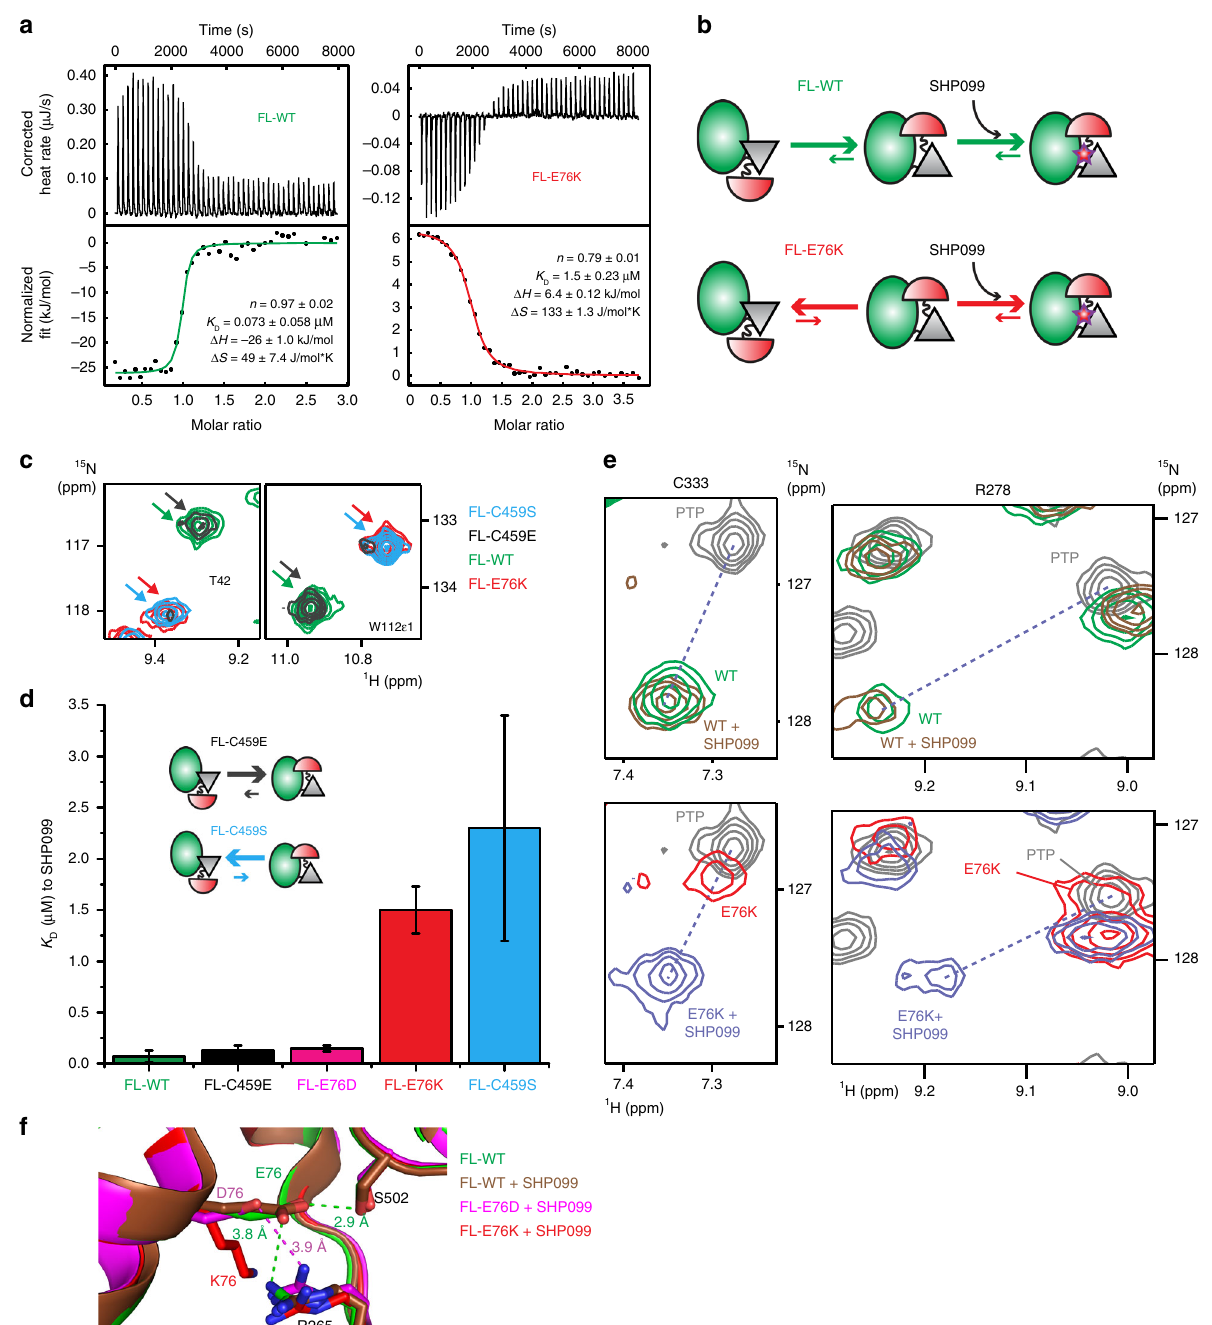
Fig. 5 Comparing thermodynamics of SHP099 binding to wild-type and mutants of SHP2. a ITC pro fi les for the binding of SHP099 to FL-WT and FL-E76K (left, 30.5 μ M of FL-WT titrated with 320 μ M of SHP099; right, 82 μ M of FL-E76K titrated with 800 μ M of SHP099). b Scheme representing the proposed SHP099 binding mechanism with inverted equilibria between open and closed conformations as illustrated by size of kinetic arrows. c Selected regions of NMR spectra show that FL-C459E and FL-C459S resemble FL-WT and FL-E76K, respectively. d Bar graph summarizing the SHP099 dissociation constants determined by ITC for the denoted proteins (see also Supplementary Fig. 6e-f) together with a scheme for the open/close equilibrium of the dead mutants; uncertainties were derived from the fi t to the data. e Chemical shift analysis to determine the population of the closed forms of FL-WT and FL-E76K. Dashed lines indicate the linear path between peaks in the PTP and FL-WT + SHP099 spectra. Using PTP and SHP099-bound chemical shifts for the completely open and closed states, respectively, the fraction of the closed state for FL-WT and FL-E76K are 0.90 and 0.04, respectively. f Superimposition of FL-WT (green), and protein/drug complexes FL-WT (brown), FL-E76D (magenta) and FL-E76K bound to SHP099 (red), reveals that the E76K